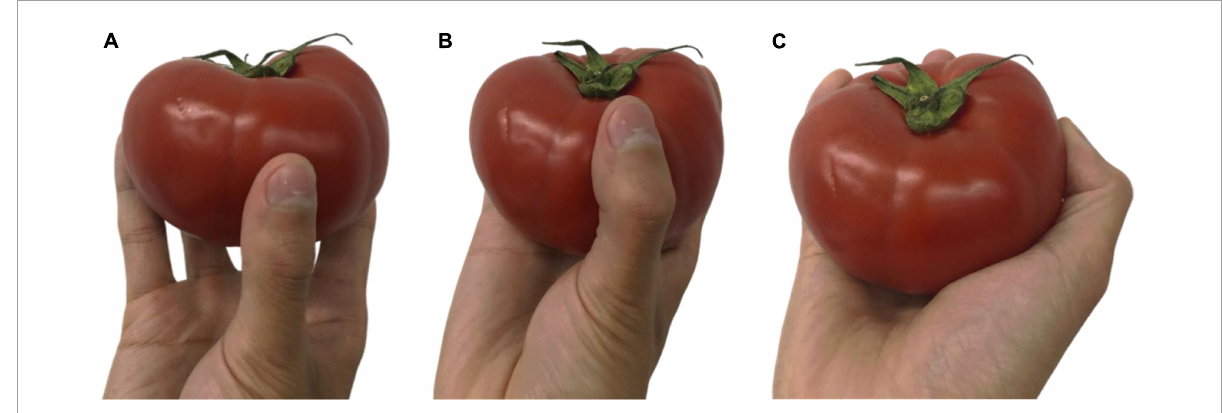
FIGURE2 Human hand holding type of tomato picking (A) fingertip pinch type; (B) semi-enclosed grip type for fingers and palms; (C) full coverage grip